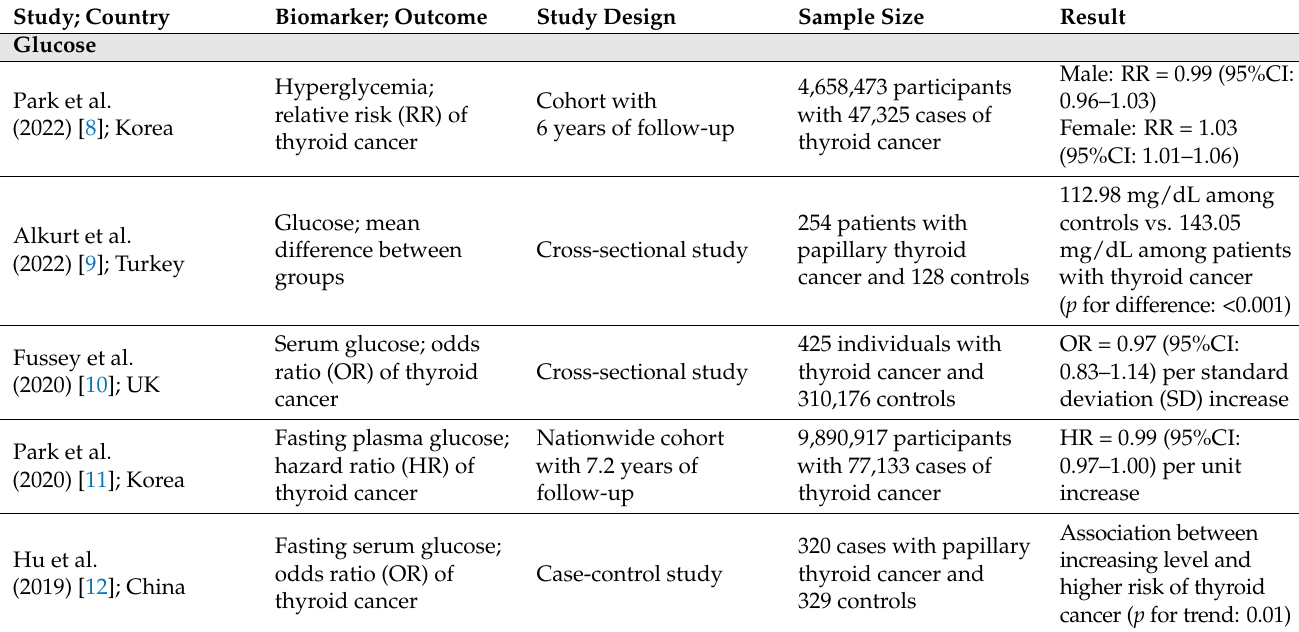
Table 1. Summary of previous studies on carbohydrate, lipid, and apolipoprotein biomarkers in the risk of thyroid